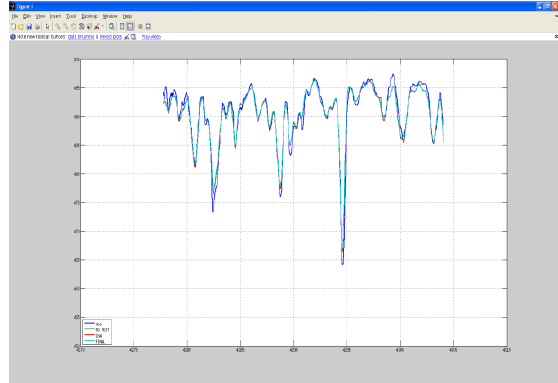
Figure 8. This graph shows a methane retrieval spectra collected over the sunglint. The dark blue line is the observation, green is with no perturbation, red is the methane amount perturbed, aqua is the reflectivity factor and purple is the final calculation with reflectivity